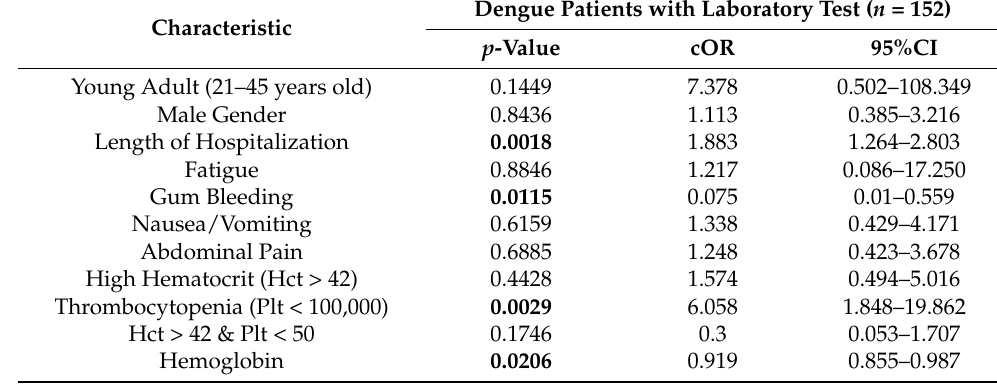
Table 4. Multivariate Analysis to Evaluate Factors Related to Dengue Hemorrhagic Fever in Dengue Patients with a Laboratory Test.